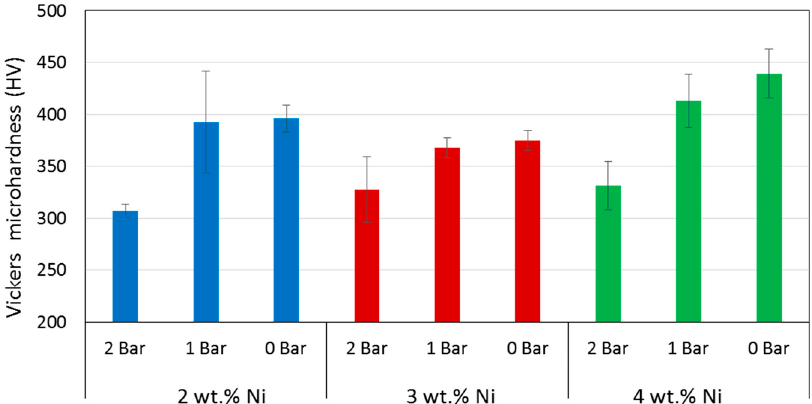
Figure 10. Summary of Vickers microhardness determined for the alloys.